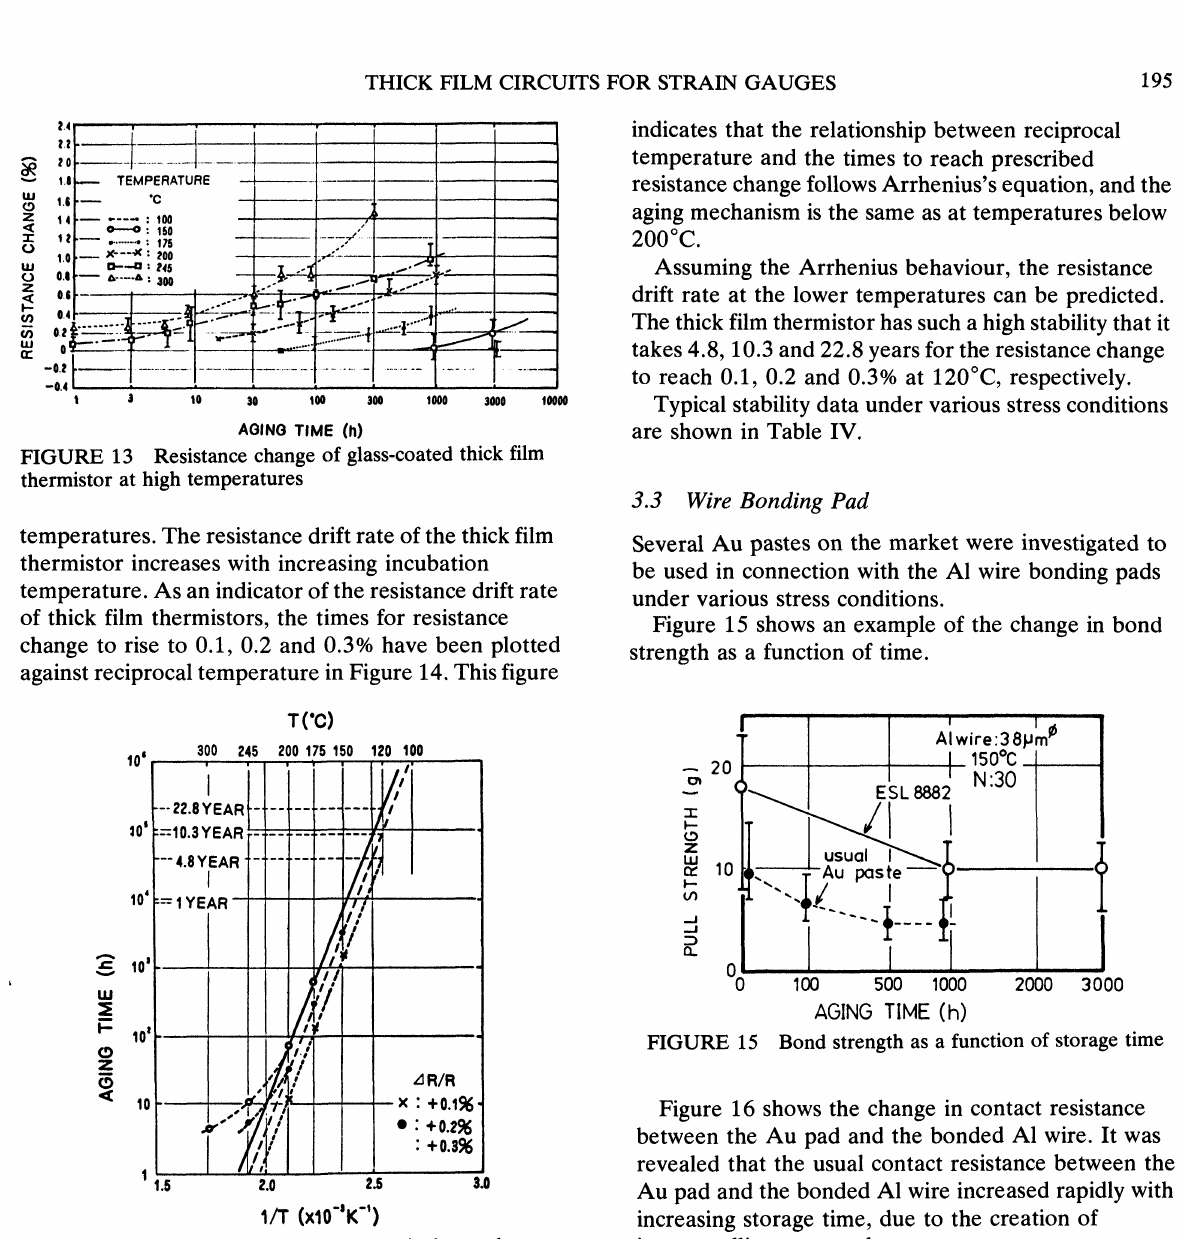
FIGURE 15 Bond strength as a function of storage time Figure 16 shows the change in contact resistance between the Au pad and the bonded A1 wire. It was revealed that the usual contact resistance between the Au pad and the bonded A1 wire increased rapidly with increasing storage time, due to the creation of intermetallic compounds. FIGURE 14 Time-temperature equivalence plot TABLE IV Stability of the thick film thermistor under various stress